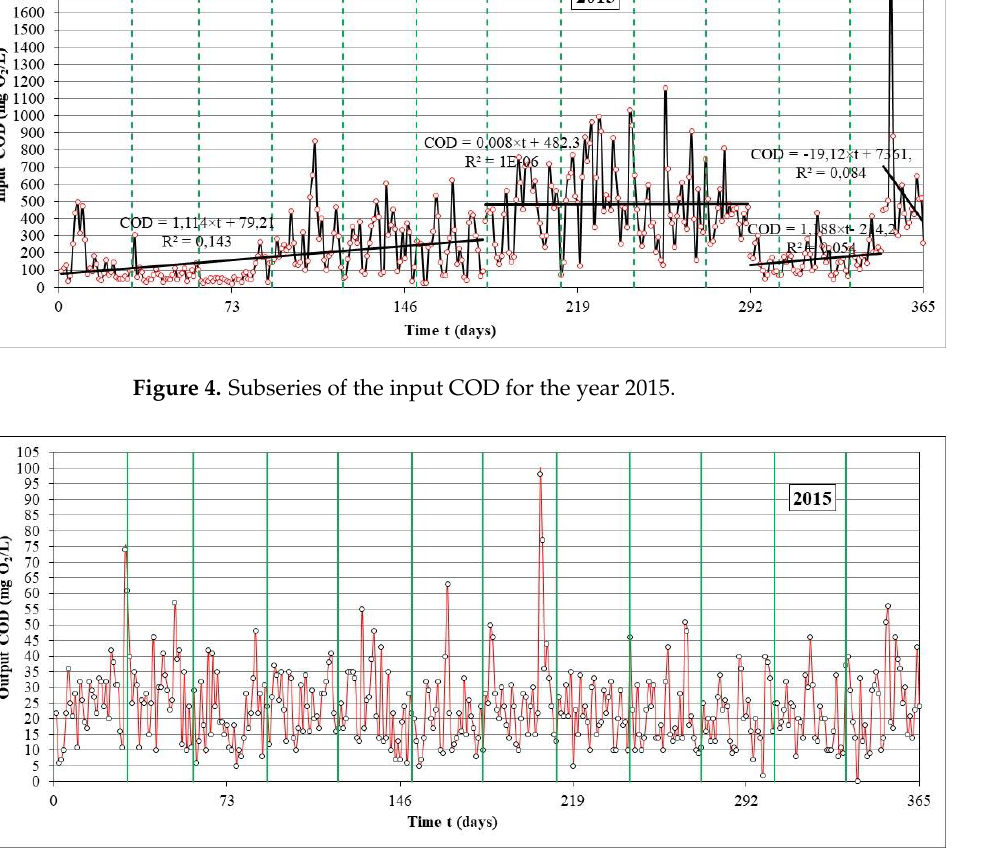
Figure 6. RAPS of the output COD for year 2015.